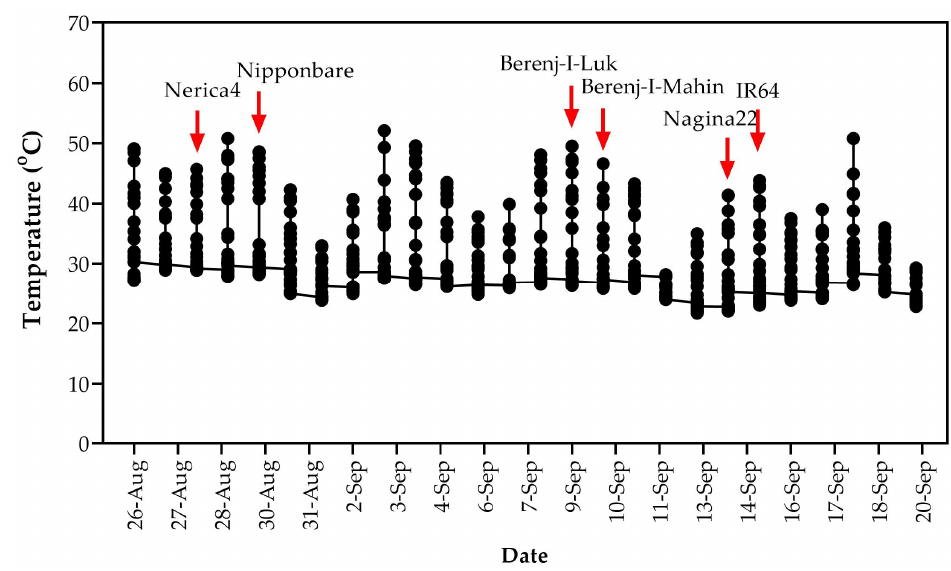
Figure 1. The graph shows the daily temperature changes during the heat stress treatment on an hourly basis. The days to flowering varied among all rice genotypes, as depicted in the graph. The red arrows indicate the specific start time of the heat stress treatment for each genotype.